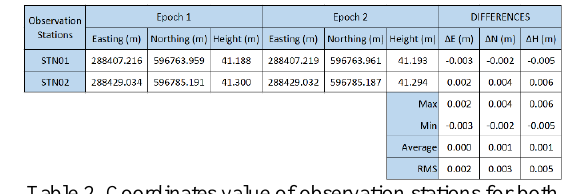
Table 2. Coordinates value of observation stations for both